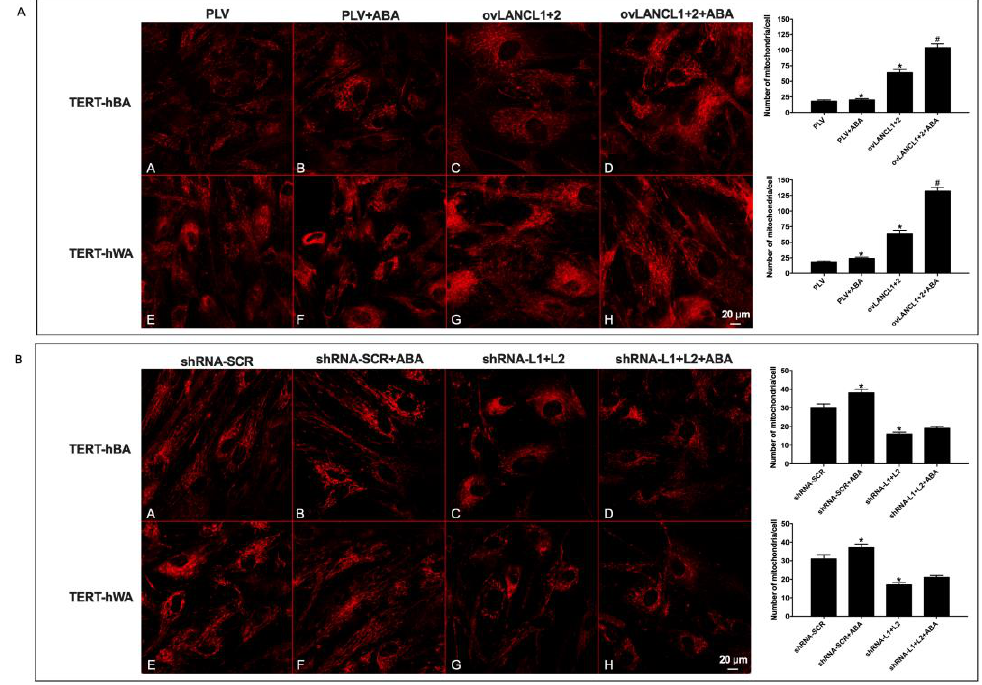
Figure 7. Mitochondrial number increases in LANCL1/2-overexpressing, and is conversely reduced in LANCL1/2-silenced white and brown adipocytes. The mitochondrial number was evaluated by MitoTracker analysis in TERT-hBA and TERT-hWA cells overexpressing LANCL1 and LANCL2 (ovLANC1+2) or double-silenced for the expression of both proteins (shRNA-L1+L2), and their respective controls, cells infected with the empty vector (PLV) or with the scrambled silencing sequences (shRNA-SCR), treated or not with 100 nM ABA. Representative confocal microscopy images of brown (panels A–D) and white (panels E–H)) adipocytes overexpressing ( A ) or silenced ( B ) for LANCL1 and LANCL2. The bar diagrams show the mean number of mitochondria per cell in each experiment (approx. 10 cells analyzed/cell type). The mean ± SD of the relative mitochondrial fluorescence was always calculated in at least 3 microscopic fields. * p < 0.005 relative to untreated control cells and # p < 0.01 relative to ABA-treated control cells by unpaired t